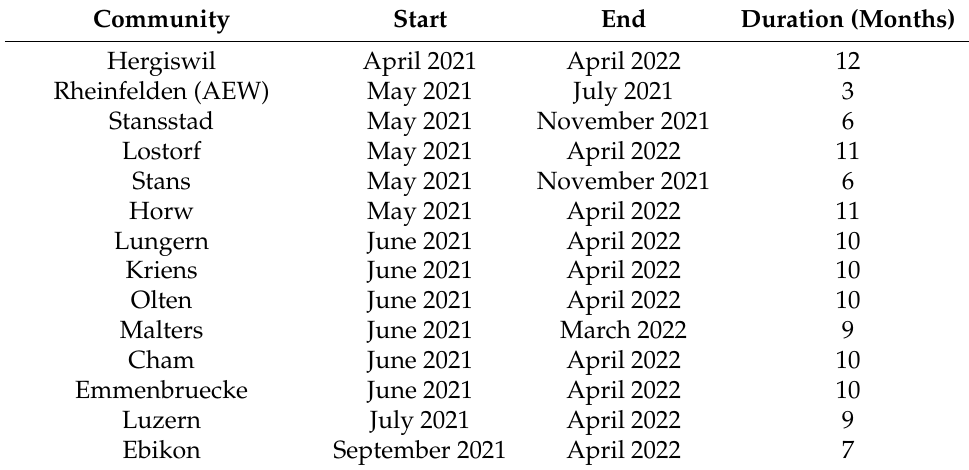
Table 4. Pilot overview of the field test measurement